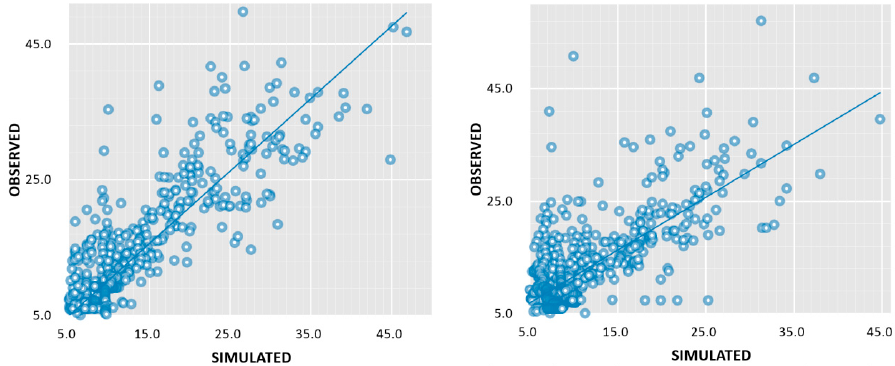
Figure 9. Daily runoff (2009–2013) of Hot Spring station derived from the SWAT model driven by the CMADS.